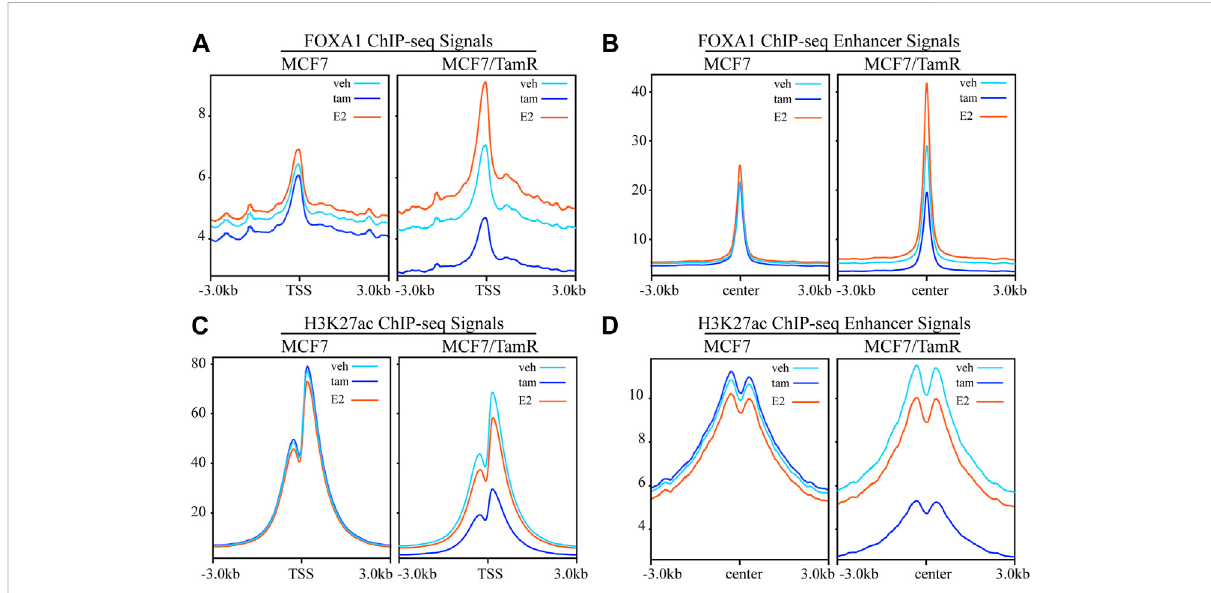
The FOXA1 and H3K27ac ChIP-seq signals in the promoter and enhancer regions. The FOXA1 ChIP-seq signals of MCF7 and MCF7/TamR cells treated with vehicle (veh), tamoxifen (tam) and estradiol (E2) around the TSS (A) or enhancer center (B) . The H3K27ac ChIP-seq signals of MCF7 and MCF7/TamR cells treated with vehicle (veh), tamoxifen (tam) and estradiol (E2) around the TSS (C) or enhancer center (D) . Light blue line, dark blue line and light red line respectively represent vehicle (veh), tamoxifen (tam) and estradiol (E2)